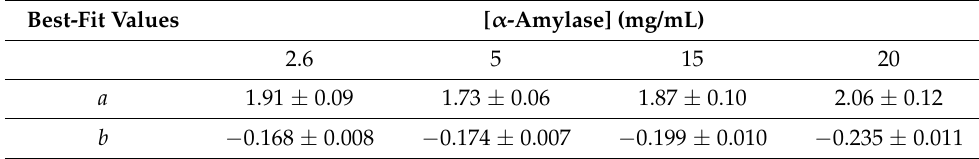
Table 1. Values of a and b coefficients ( y = ax b ) for each α -amylase concentration used. Best-Fit